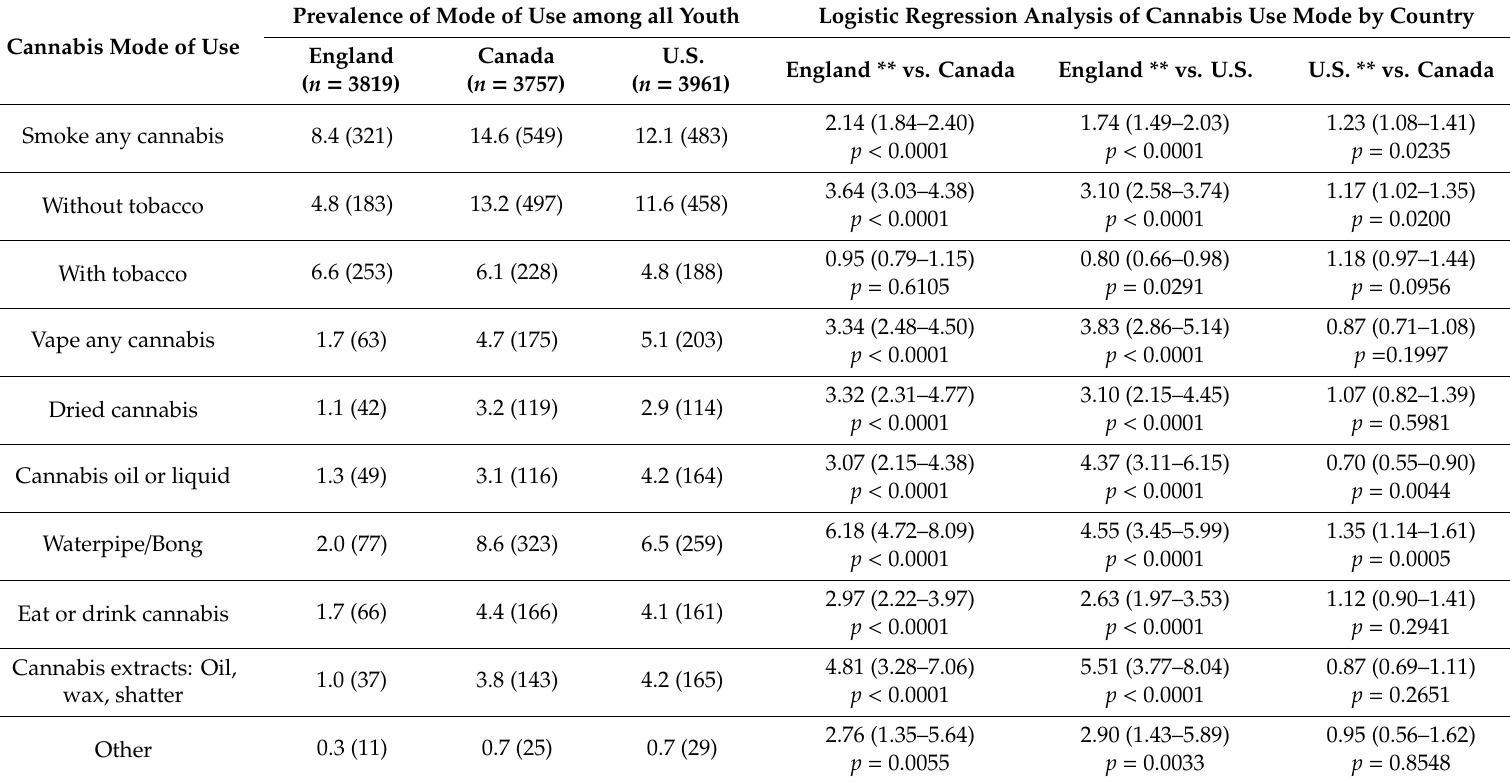
Table 2. Prevalence of past 30-day cannabis modes of use among all youth and binary logistic regression analysis of cannabis modes of use by country (weighted) *. Prevalence of Mode of Use among all Youth Logistic Regression Analysis of Cannabis Use Mode by Cannabis Mode of Use